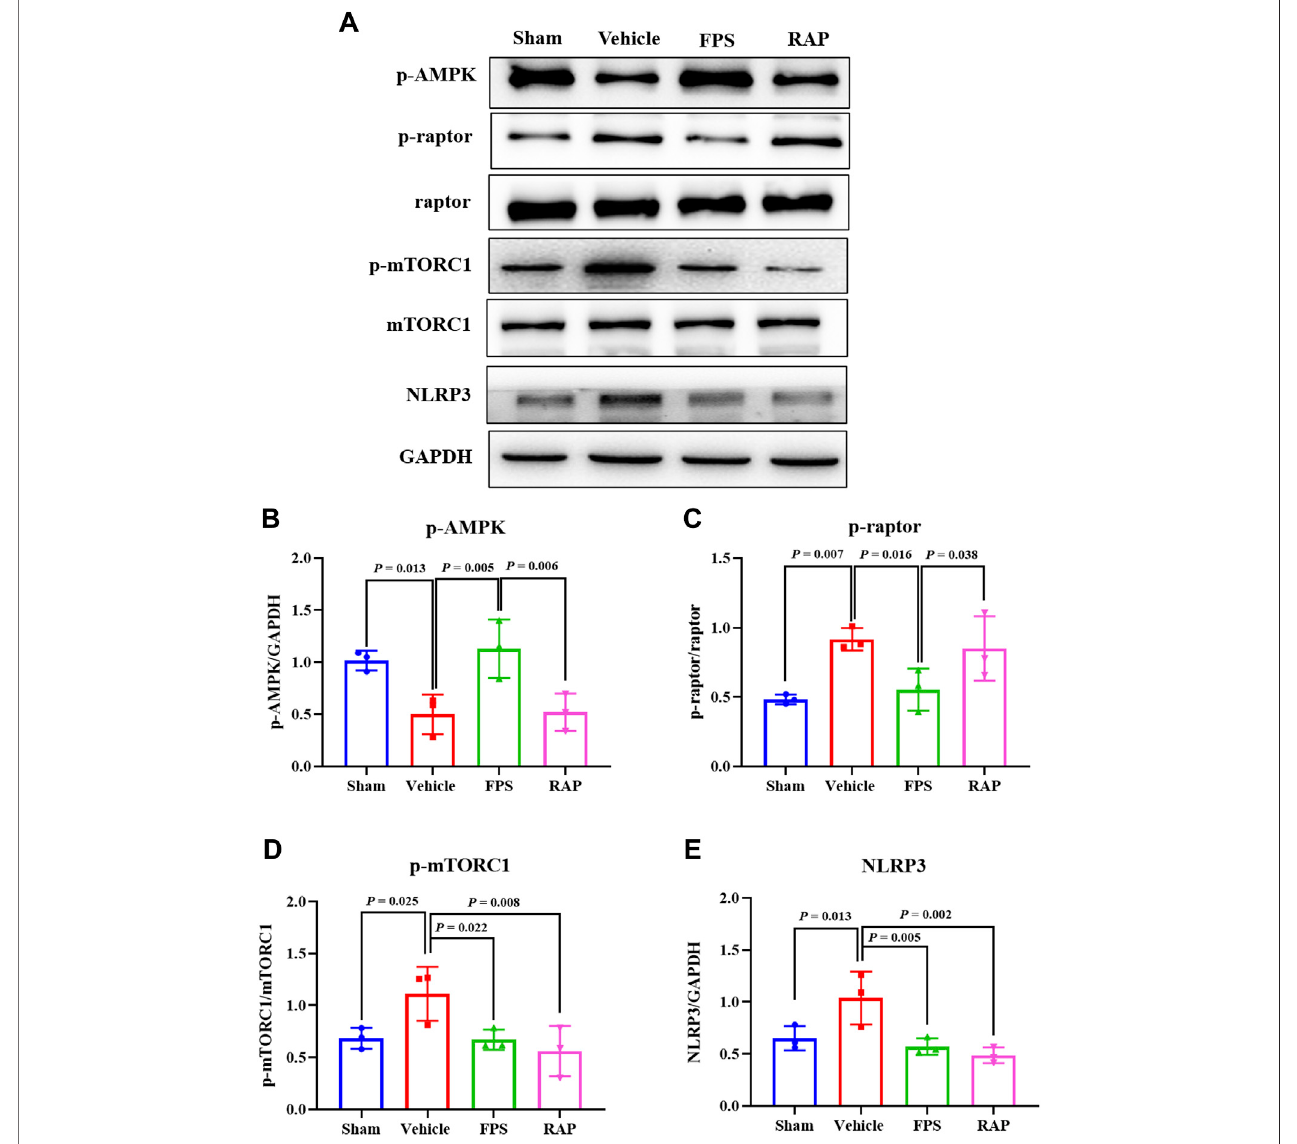
FIGURE 13 | Effects of FPS and RAP on the AMPK/mTORC1/NLRP3 signaling axis in vivo . (A) The WB analysis of the key signaling molecules in the AMPK/ mTORC1/NLRP3signalingaxisinthediabetickidneys. (B – E) Therateofp-AMPK,p-raptor,p-mTORC1,andNLRP3toGAPDHorraptorormTORC1,respectively.The data are expressed as the mean ±